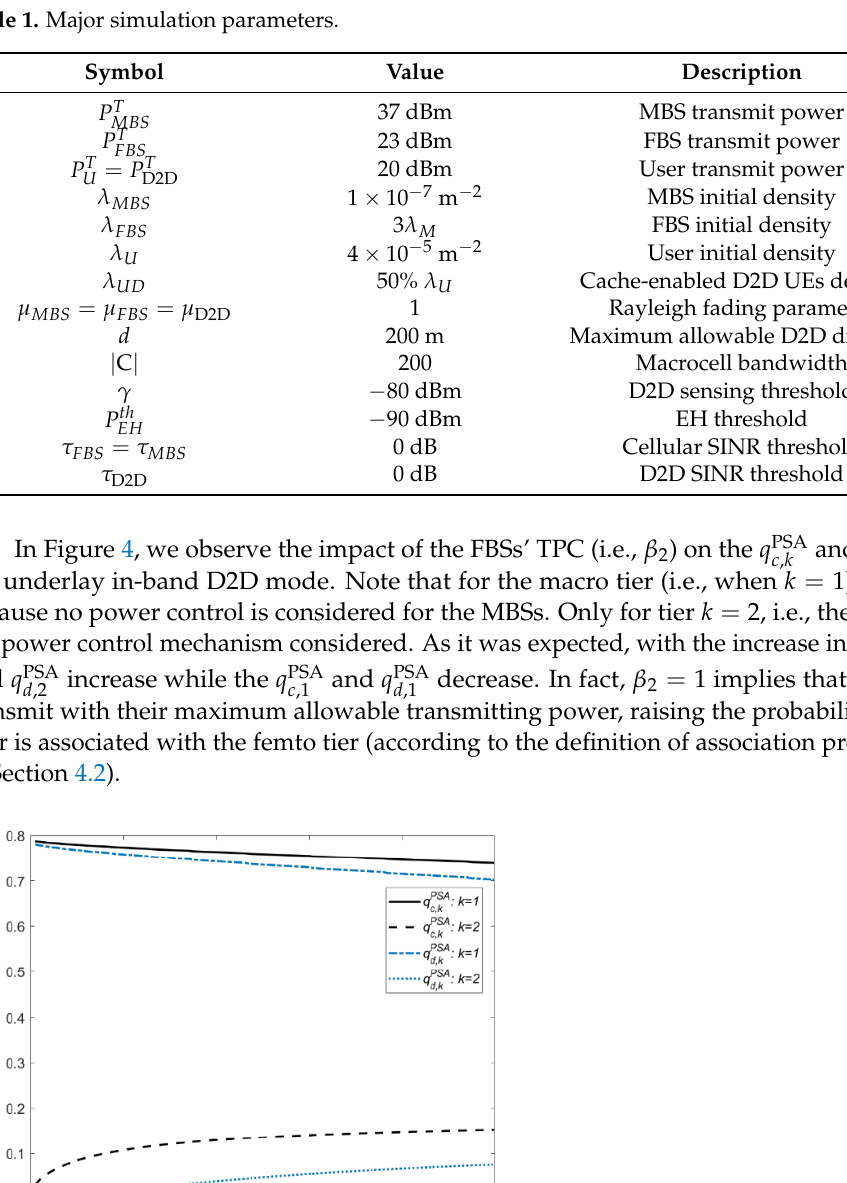
Table 1. Major simulation parameters.